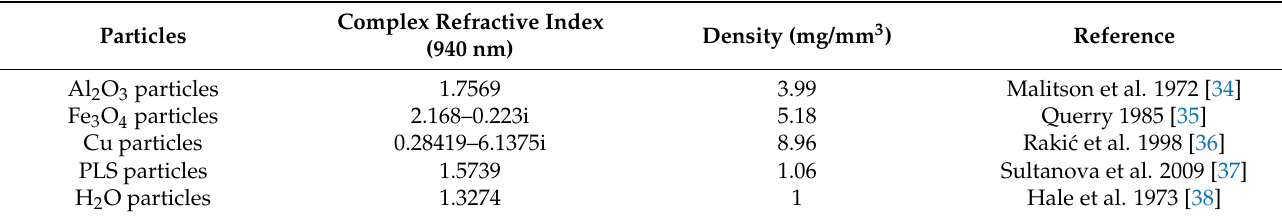
Table 1. Complex refractive index and density of five solid